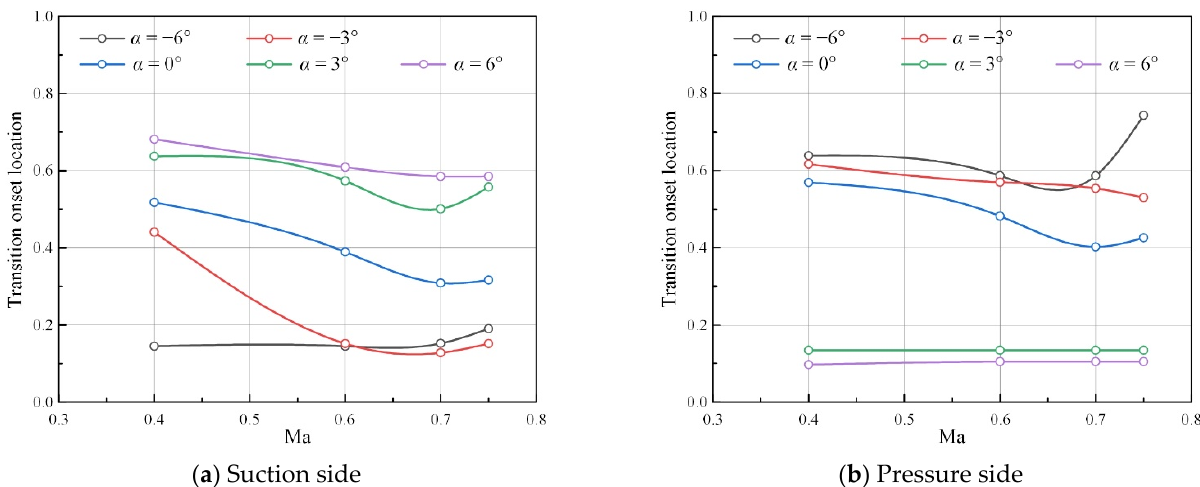
Figure 17. Transition onset locations under various Mach numbers ( ε = 0.5%, T w = 293 K).